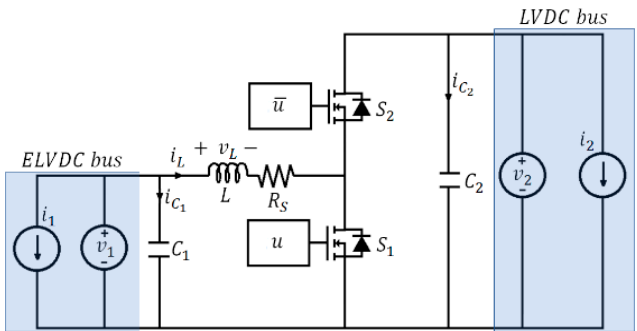
Figure 2. Complete circuit model of the half-bridge converter as the interlinking device between microgrid DC buses.